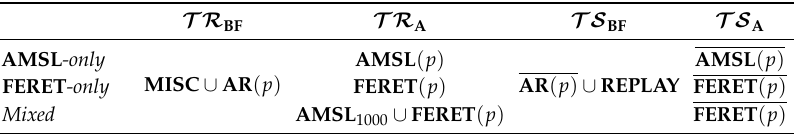
Table 1. Training/testing scenarios adopted in Section